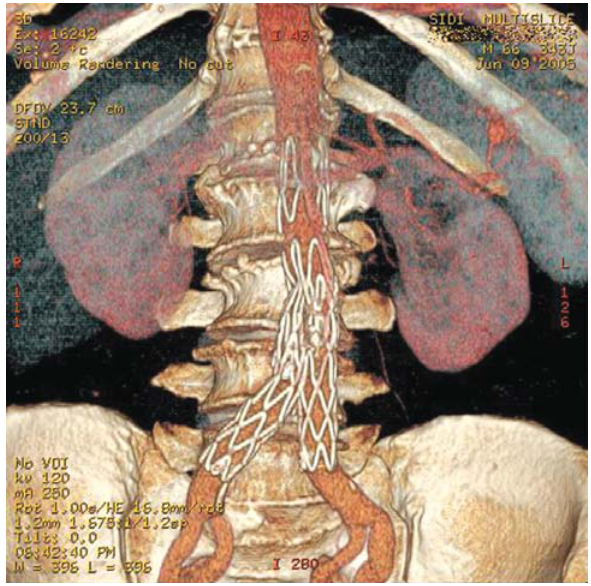
Angiotomografia 1 ano após correção endovascular de AAA